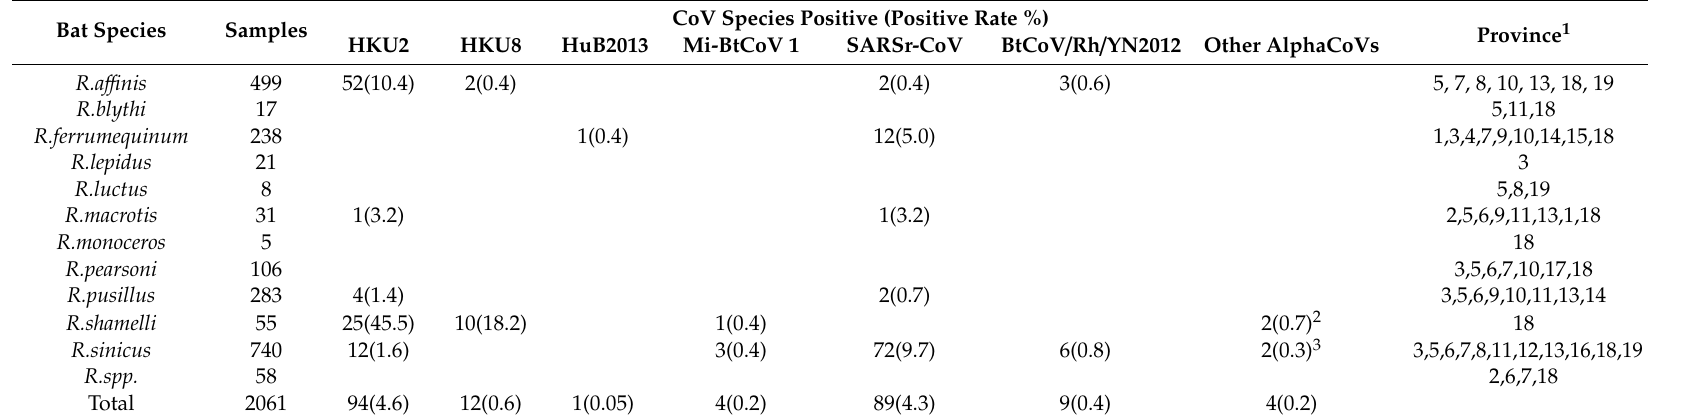
Table 1. Detection of CoVs in Rhinolophus bats by